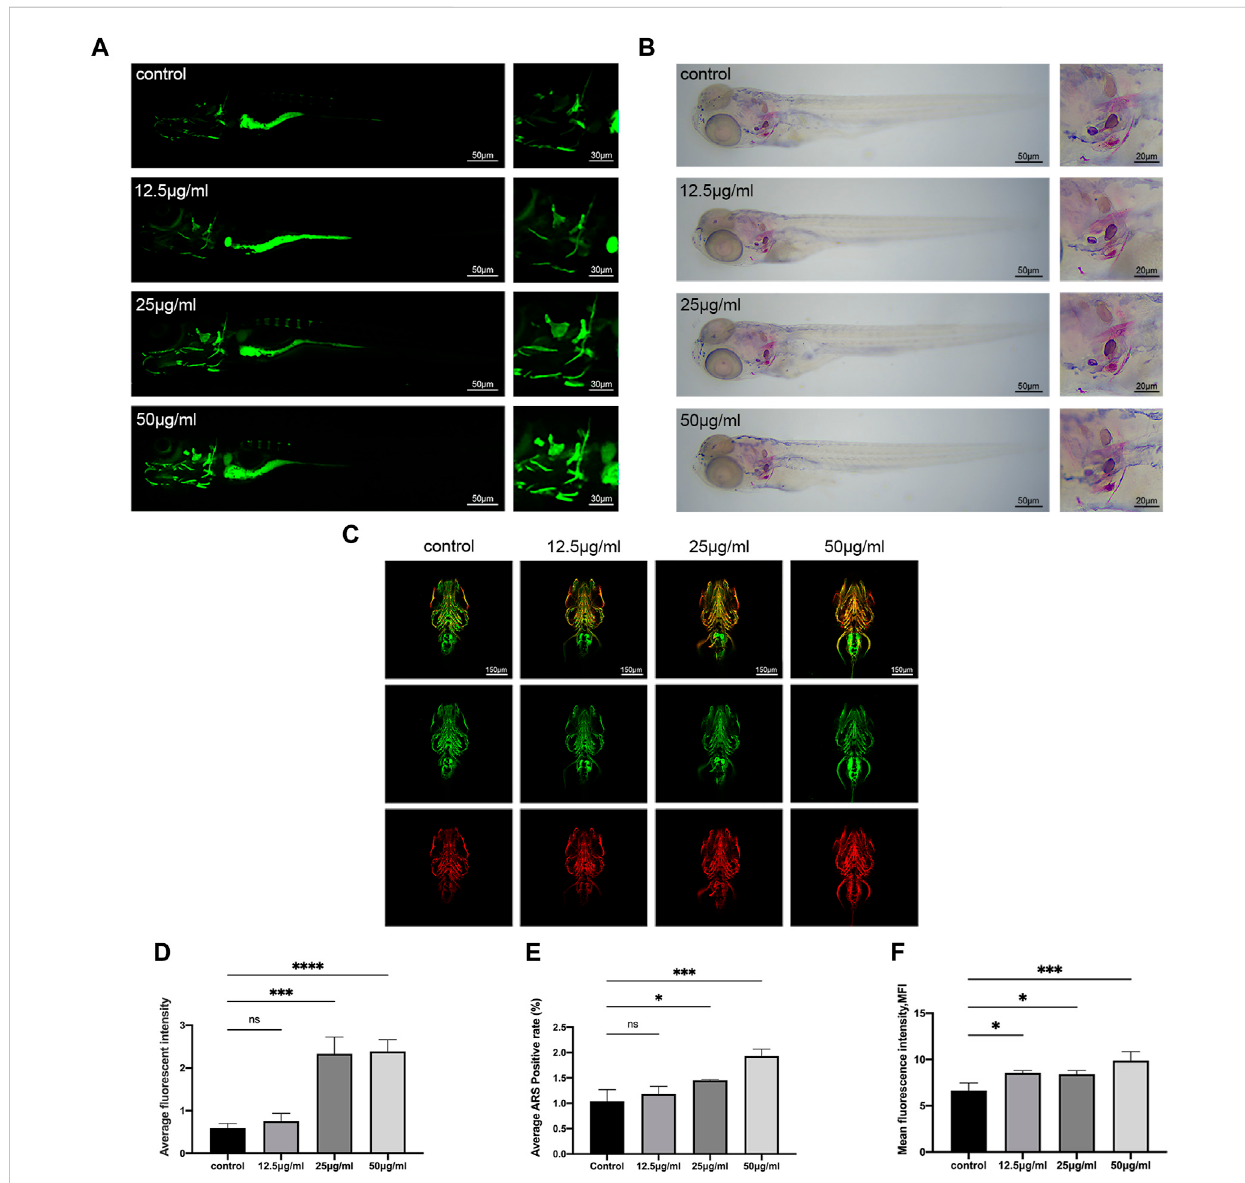
FIGURE 3 TheeffectofLPKonzebra fi shlarvaemineralization invivo . (A) Invivo calceinstainingof9dpfzebra fi shlarvaeexposedtodifferentconcentrationsof LPK under ×4 and ×10 magni fi cation. (B) ×4 and ×10 magni fi ed zebra fi sh larvae with ARS fi xed staining. (C) Immuno fl uorescence double staining of zebra fi sh larvae at ×10 magni fi cation, ZNS5 expressed in green fl uorescence and COL1A1 expressed in red fl uorescence. (D) In average optical density analysis,comparedtothecontrolgroup,opticaldensitiesweresigni fi cantlydifferentat p < 0.0005(***); p < 0.0001(****);ns:thedifferencewasnot statistically signi fi cant. (E) ARS positive area quantitative analysis; compared to the control group, signi fi cant differences were de fi ned at p < 0.05 (*); p < 0.0005 (***); ns: the difference was not statistically signi fi cant. (F) The average optical density analysis of red fl uorescence; compared to the control group, differences were signi fi cantly different at p < 0.05 (*); p < 0.0005